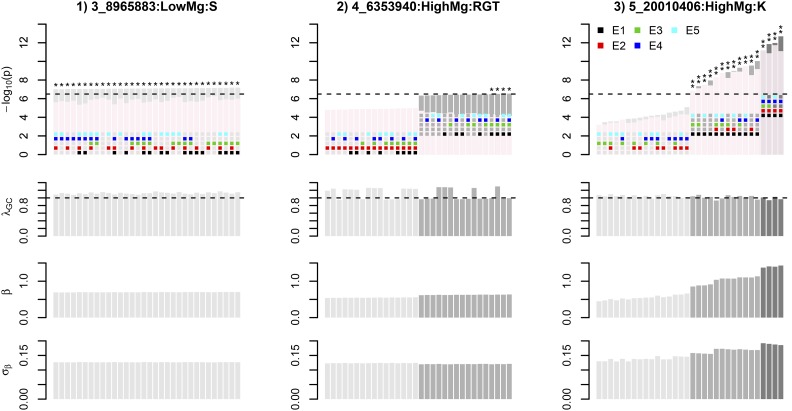
Evaluation of the modeling for three OATH hits. The top four rows represent –log10(p),
λGC,
β, and σβ, estimated using 32 possible OATH models given five covariates for these three SNPs. –log10(p),
λGC,
β, and σβ are in ascending order according to their –log10(p). In the top row, the corresponding OATH models are denoted by colored squares, indicating the inclusion or exclusion of covariates; there are two bars, gray and pink, in each cluster, representing –log10(p) with or without adjustment for λGC. An asterisk indicates that this (SNP) is significant under the corresponding model without adjustment for λGC; three asterisks indicate that this SNP is significant under the corresponding model, both with and without adjustment for λGC. OATH, Open GWAS algoriTHm; SNP, single nucleotide polymorphism.